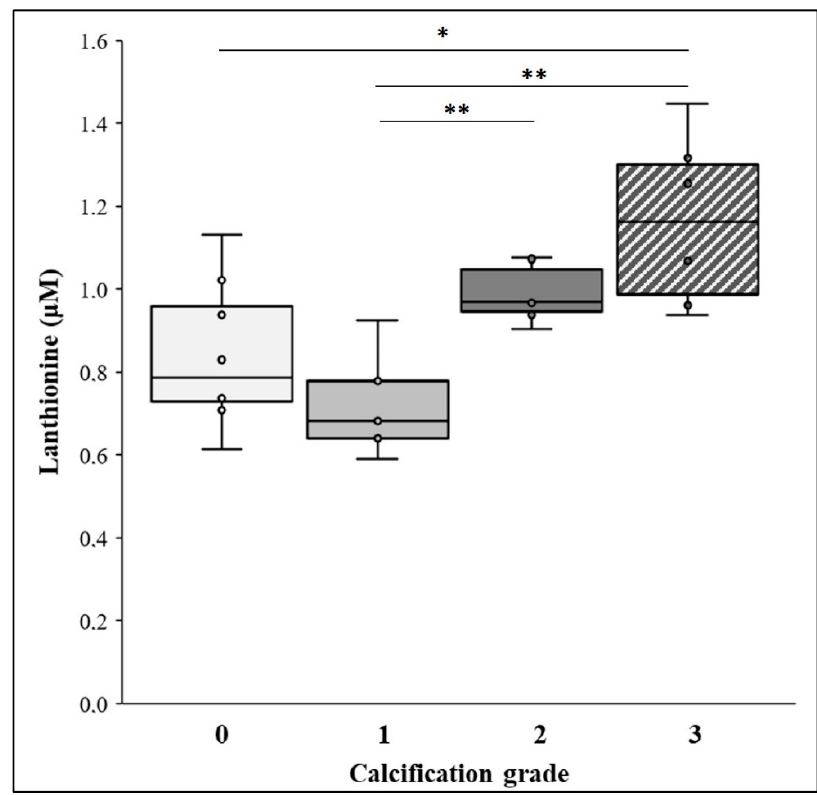
Figure 2. Plasma lanthionine levels and calcification grade. The box whisker plot represents lanthionine ( μ M) in different calcification grades. The calcification grade was based on the level of coronary artery calcification (CAD), detected by computed tomography (CT) scan, expressed as a calcium score. Agatston score 0 ( n = 8; 32%), Agatston score 1 ( n = 5; 20%), Agatston score 2 ( n = 6; 24%) and Agatston score 3 ( n = 6; 24%). Within each box, the horizontal black lines represent the median values. p -values: Agatston score 0 versus 3 * p < 0.05; Agatston score 1 versus 2 and 3 ** p ≤ 0.01, according to the Mann–Whitney U test following the omnibus Kruskal–Wallis test.